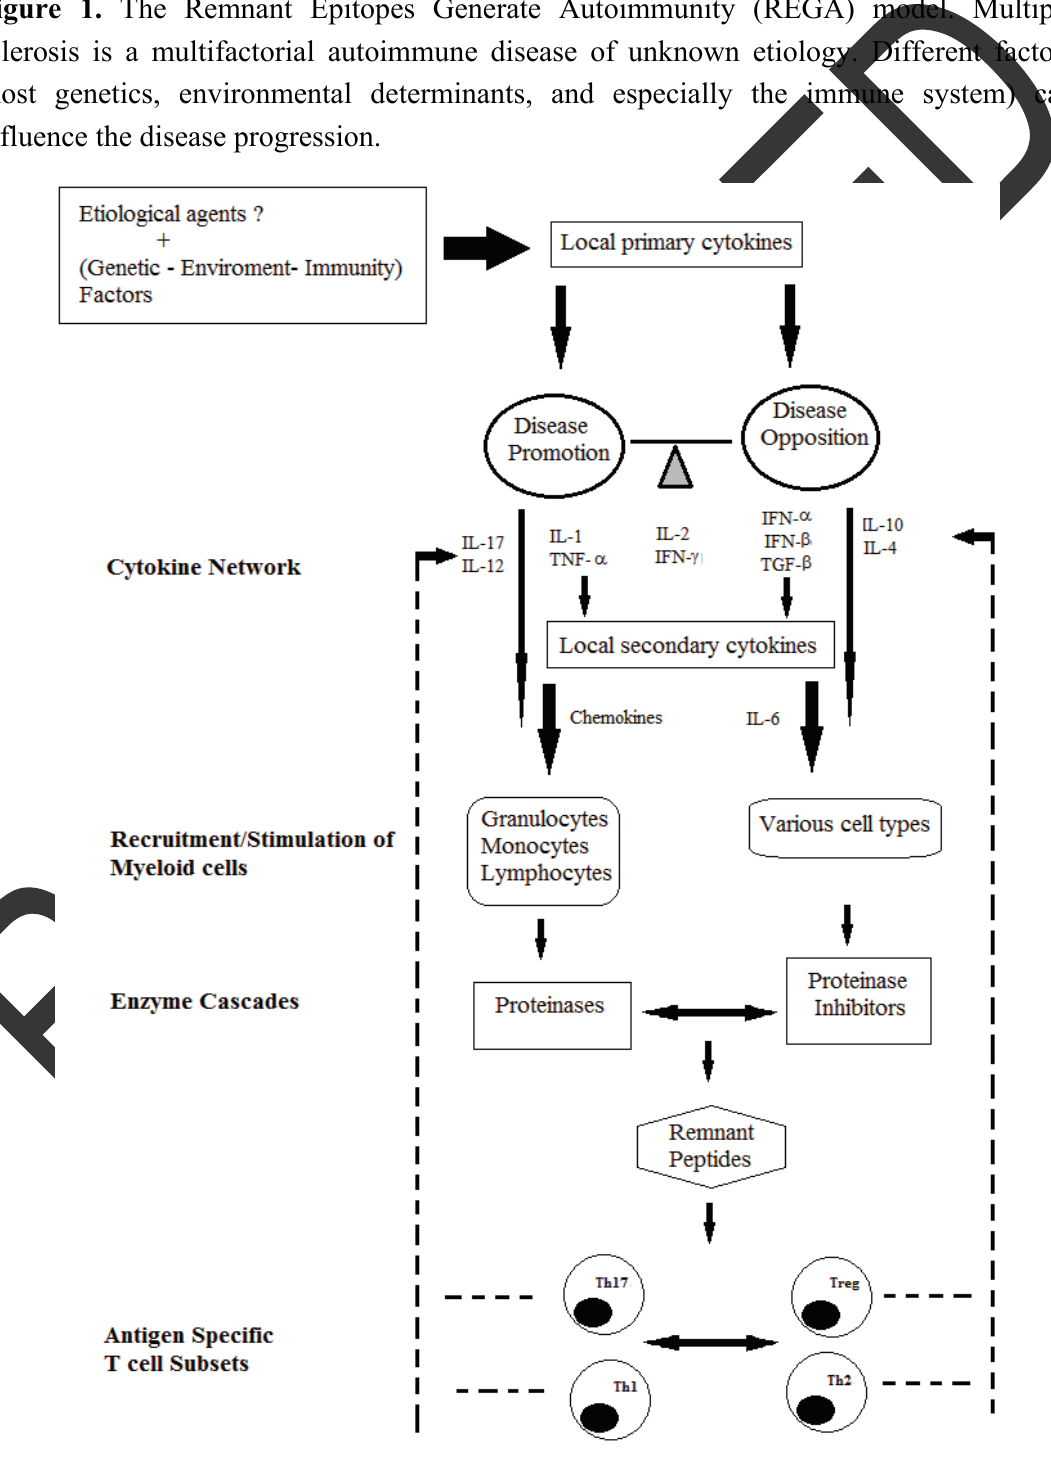
Figure 1. The Remnant Epitopes Generate Autoimmunity (REGA) model. Multiple sclerosis is a multifactorial autoimmune disease of unknown etiology. Different factors (host genetics, environmental determinants, and especially the immune system) can influence the disease